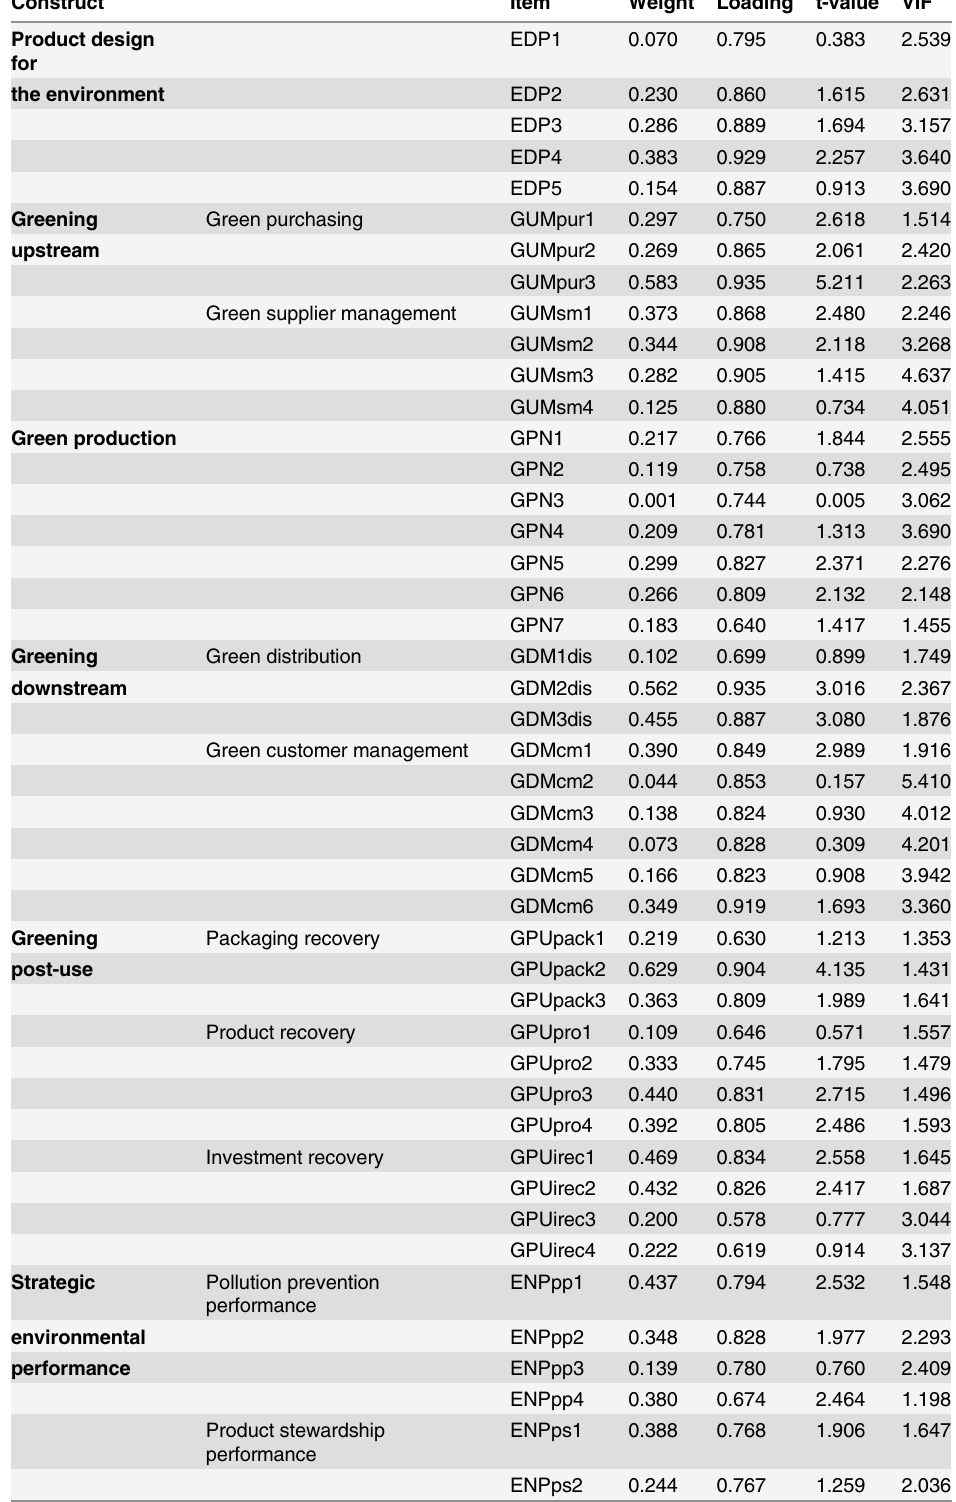
Table 5. Evaluation of formative measurement